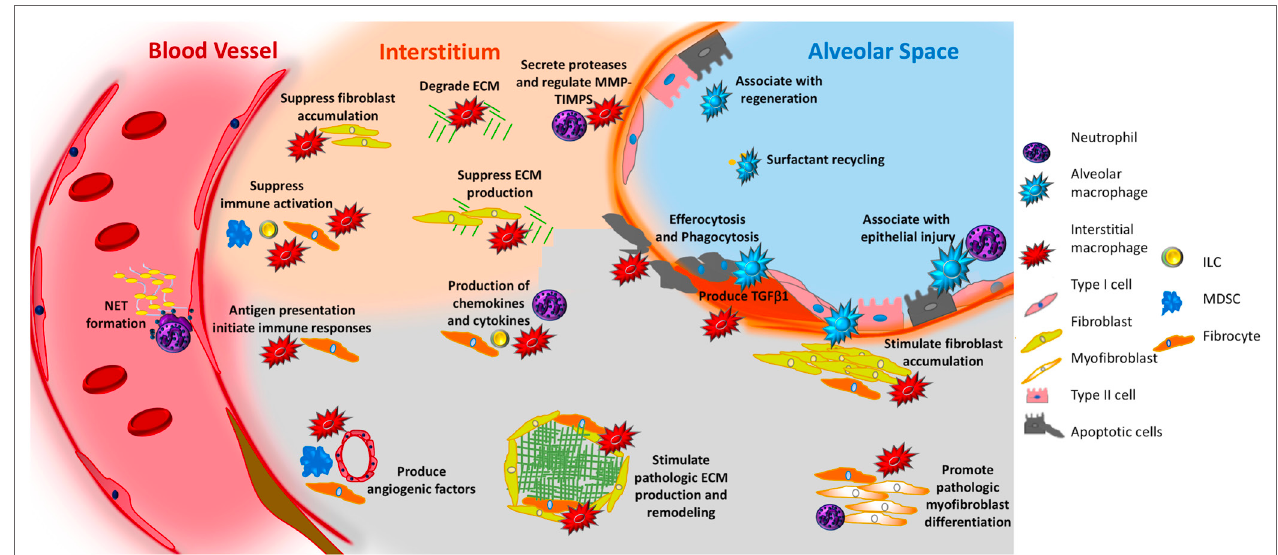
FigURe 2 | Potential role of innate immunity in pulmonary fibrosis. In response to interactions with pathogen-associated molecular patterns or danger-associated molecular patterns, or to stimulation with various mediators, macrophages—both alveolar (aqua irregular shape) and interstitial (red irregular shape)—can adopt fibrosis modifying properties. These functions include production of TGF β 1, production of soluble mediators that cause fibroblast accumulation and activation, production of TIMPS and MMPS that participate in extracellular matrix (ECM) remodeling, production of angiogenic factors, secretion of lipid mediators, regulation of structural cell injury and stem cell renewal, and surfactant recycling. Neutrophils (purple polymorphonuclear circle) produce neutrophil elastase (NE), TIMPS, and MMPs that dictate whether ECM accumulates or is degraded. Neutrophils also participate in the formation of neutrophil extracellular traps, which may promote fibrosis via the production of TGF β 1 and subsequent myofibroblast activation. Circulating fibrocytes (orange spindle shaped cells) are bone marrow-derived mesenchymal cells that enter the lung via the vasculature. Once in the lung they adopt multiple functions that would be expected to modulate fibrogenesis including the ability to differentiate into fibroblasts and myofibroblasts, production of ECM, contraction of wounds, participate in antigen presentation, production of chemokines and cytokines, and regulation of angiogenesis via production of soluble mediators. Myeloid-derived suppressor cells (MDSC, blue) are immunosuppressive cells that show an association with ECM remodeling and pulmonary hypertension. Innate lymphoid cells (ILCs) produce cytokines that may regulate fibroblast accumulation and ECM production. In the above figure, the functions of each cell are depicted in font matching the cell’s color. Note that cells are not drawn to